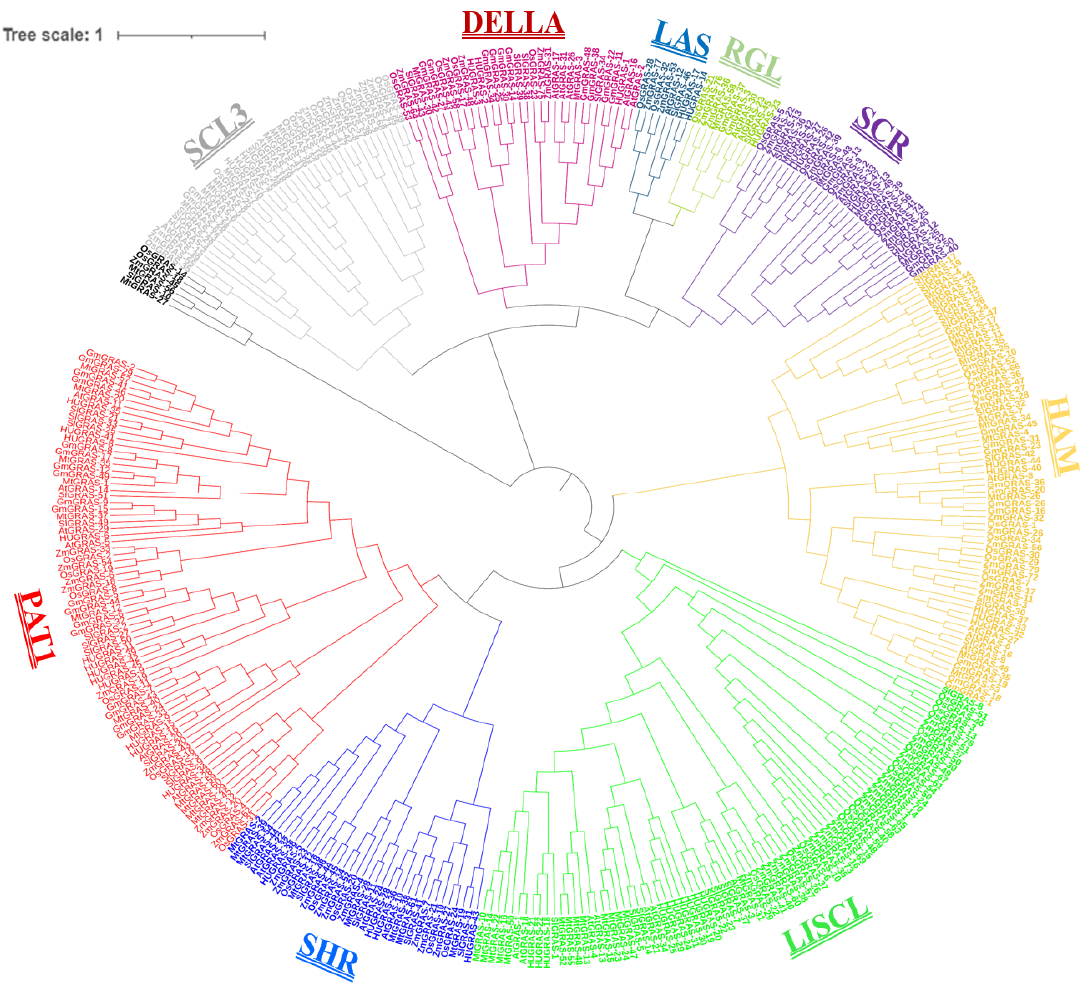
Figure 2. Characterized sequences of six species (maize, soybeans, Arabidopsis, Medicago truncatula , tomatoes and rice) were used to draw this phylogenetic tree with the pitaya GRAS genes. The GRAS proteins were divided into nine subfamilies, exhibited with different colors: PAT1 (red), SHR (navy blue), LISCL (lime), HAM (light orange/wheat color), SCR (violet), RGL (pea green), LAS (teal), DELLA (magenta pink) and SCL3 (gray).